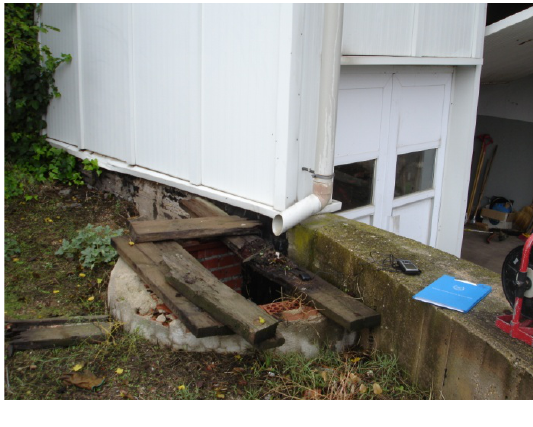
Figure 7. Example of a “very low cost” domestic MAR device in